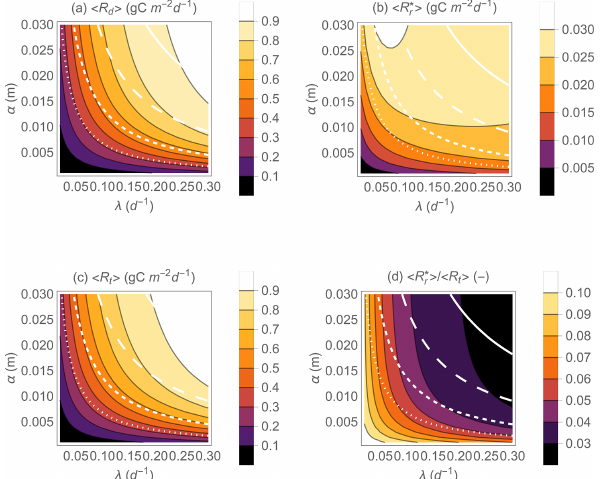
Figure 6. Effect of precipitation statistical properties (mean event frequency λ and depth α ) on the standard deviations of het- (a) and respi- erotrophic respiration rates during dry periods σ R d (b) , on the coefficients of variations ration pulses at rewetting σ R r (c) , and on respiration of respiration rates during dry periods CV R d (d) . The white contour curves indicate pulses at rewetting CV R r combinations of λ and α that generate different annual precipitation rates ( (cid:104) P (cid:105) = αλ = 0 . 25, 0.5, 1, and 2myr − 1 from dotted to solid lines). Other parameter values are as in Fig.